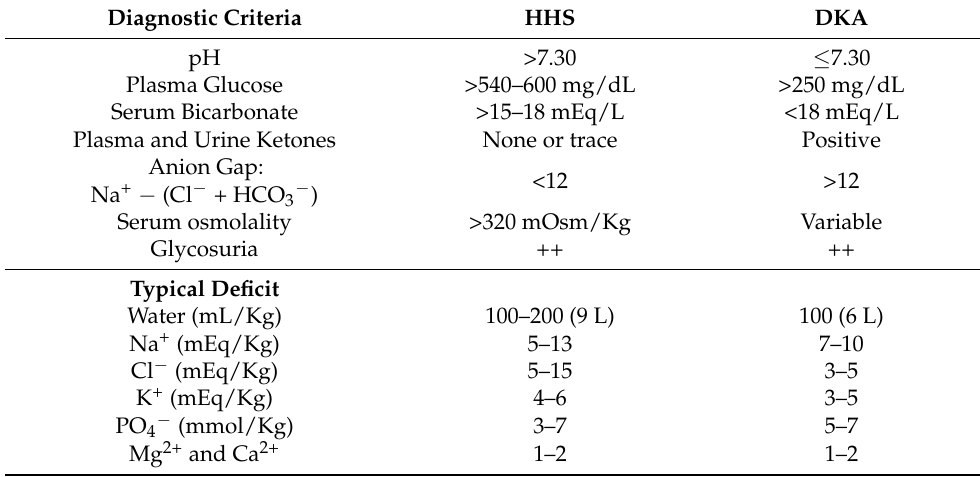
Table 2. Diagnostic criteria and typical deficits in the hyperglycemic hyperosmolar [13,36]. Na +